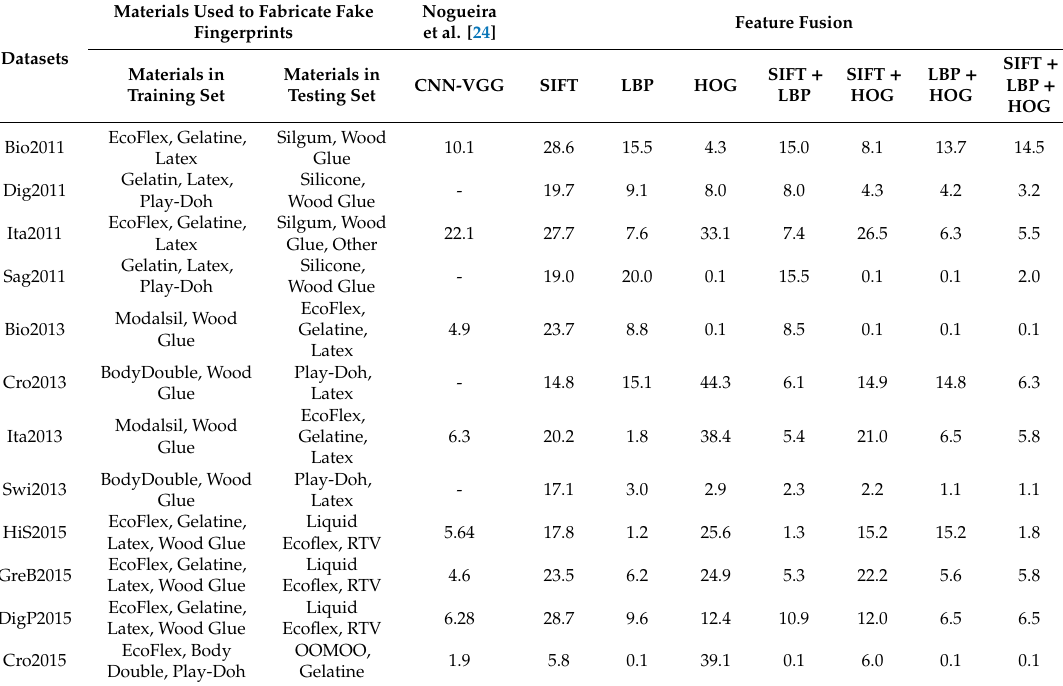
Table 8. Accuracy of di ff erent fake fingerprint materials in di ff erent datasets.